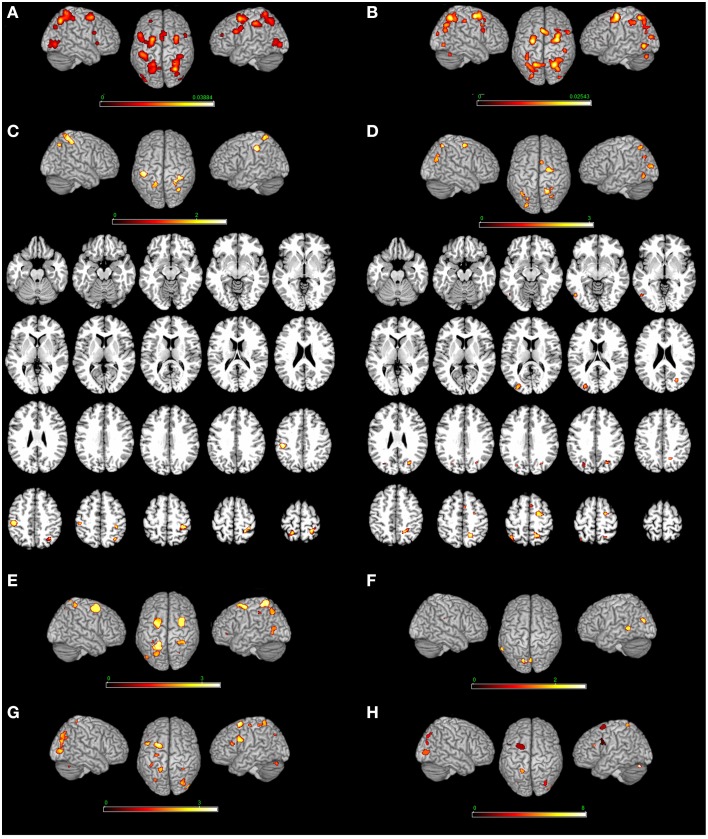
Top-down modulation of the MR network exerted by the type of strategy. [Motor imagery-based/egocentric (A) non-motor-imagery-based/allocentric (B) MR] and by the direct contrast [(C) motor imagery-based/egocentric > non-motor-imagery-based/allocentric and (D) non-motor-imagery-based/allocentric > motor imagery-based/egocentric]. (E) Motor-imagery based MR (vs. egocentric MR); (F) egocentric MR (vs. motor-imagery based MR); (G) Single stimulus (vs. pair of stimuli) presentation; (H) Pair of stimuli (vs. single stimulus). Relative increases in neural activity associated with MR induced by different types of strategies are displayed on a rendered template brain provided by spm5. Activations are significant at p < 0.05 corrected for multiple comparisons using the False Discovery Rate (FDR). In (A,B) color bar shows ALE value; in (C–F) color bar shows Z maps. The Z coordinates for each slices range from −24 to 66 (with incremental steps of 5 mm).